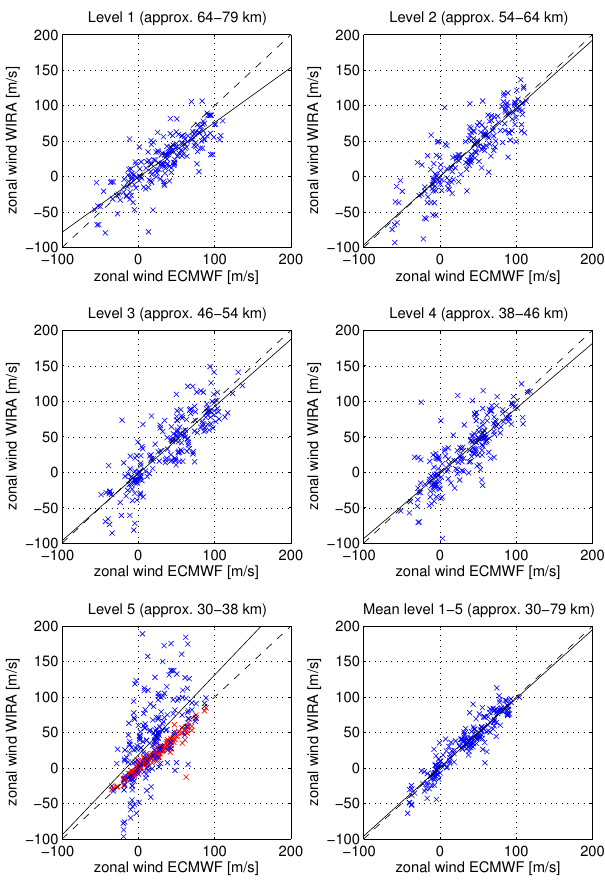
Fig. 14. Scatter plots between daily average WIRA winds retrieved with the centroid method and the ECMWF operational analysis data for the standard WIRA levels and the mean over these alti- tude ranges for the measurement period between 1 September 2010 and 31 July 2011. The solid black line is the fit through the data weighted with 1 /σ 2 whereas the dashed line represents identity. The red markers in the panel for level 5 represent the data from the radiosondes from Payerne that reached the lower pressure limit of this